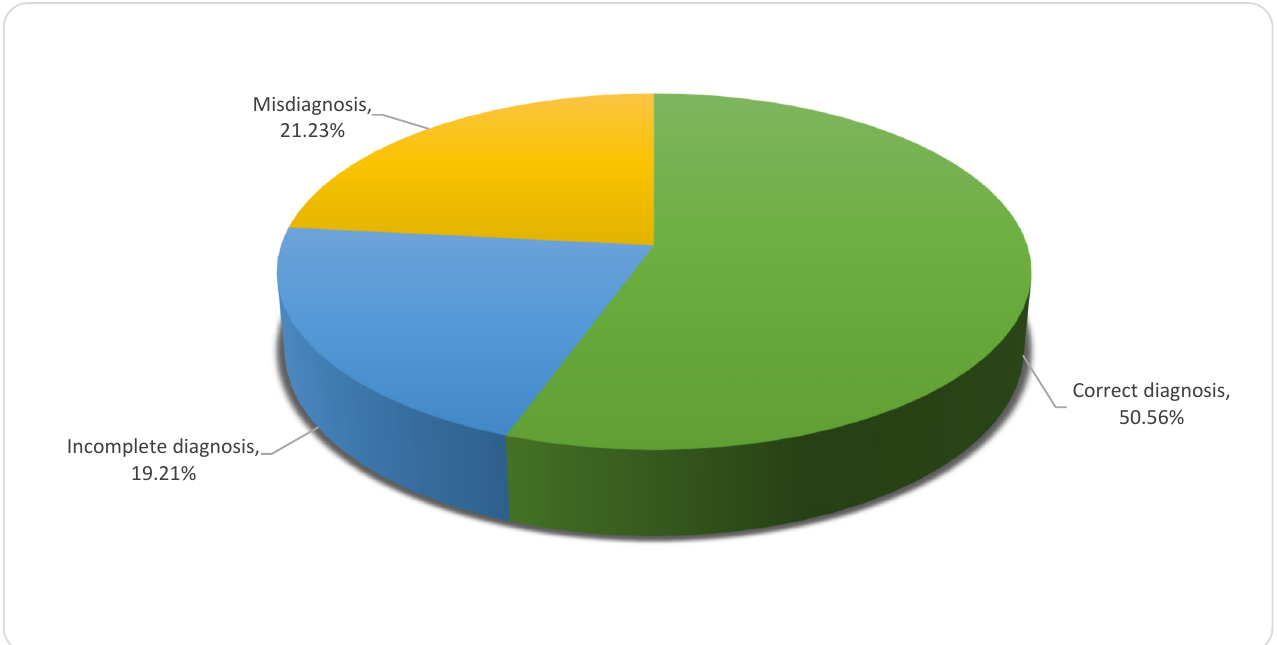
Figure 3. Overall diagnostic accuracy of atypical parkinsonian syndromes.